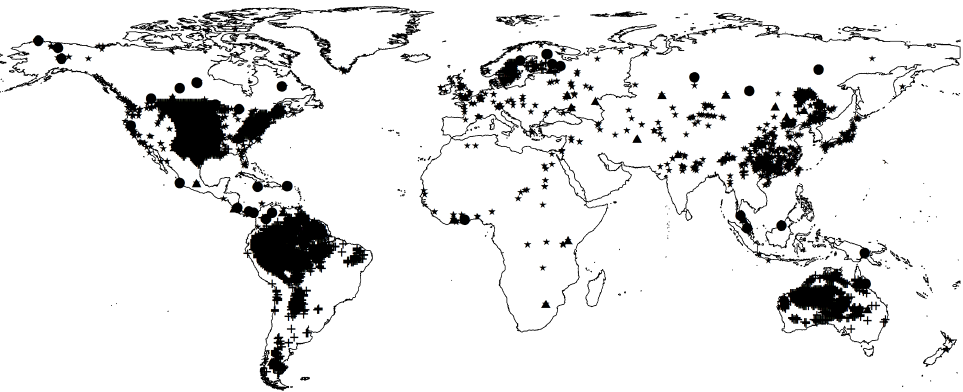
N Figure 3. Map showing the geographical distribution of detailed terrestrial NPP study sites. The dataset are obtained from the Oak Ridge = grassland sites included in the present analysis; m = NPP study sites National Laboratory (ORNL), Distributed Active Archive Center database. forests (tropical forest, temperate forest and boreal forest), w and + = multi biomes – EDMI (B and C) data [63]. These data, and further information about the study sites, are publicly available at www.daac.ornl.gov/NPP/.